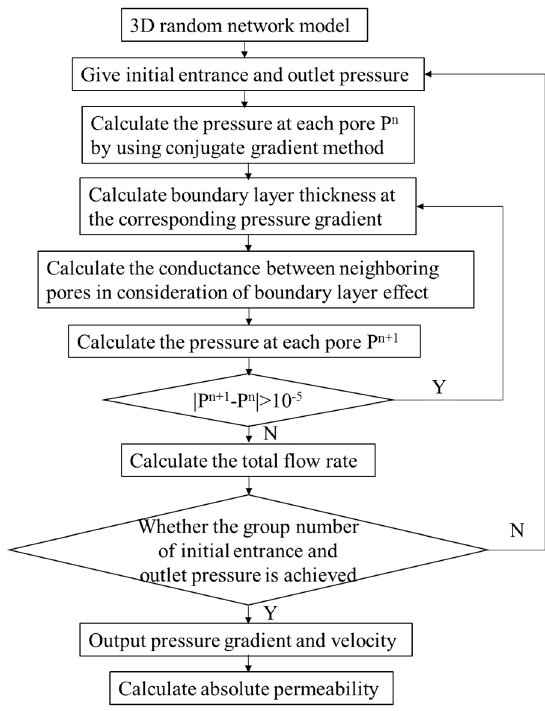
Figure 16. Flow chart of calculation in consideration of fluid-solid interaction. The calculation results are shown in Figure 17.